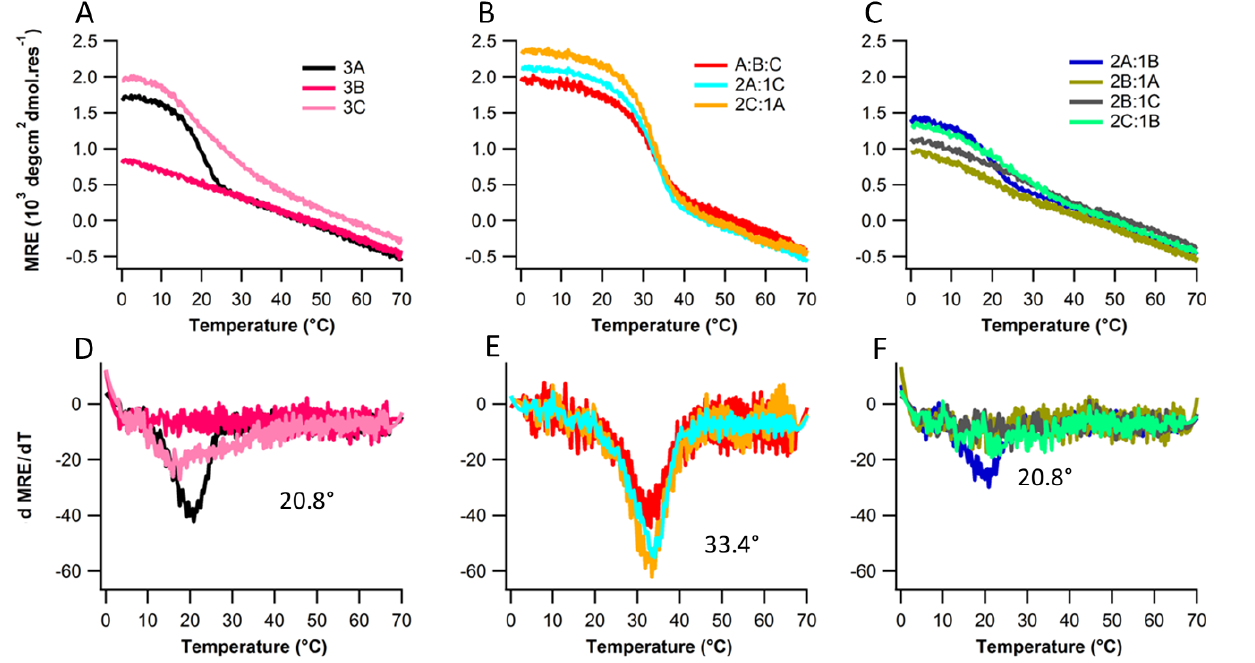
Figure 2. Thermal denaturation (top row) and their respective first derivative plots (bottom row) for peptide mixtures ( A and D ) 3A, 3B, 3C ( B and E ) A:B:C, 2A:C, A:2C ( C and F ) 2A:B, A:2B, 2B:C,